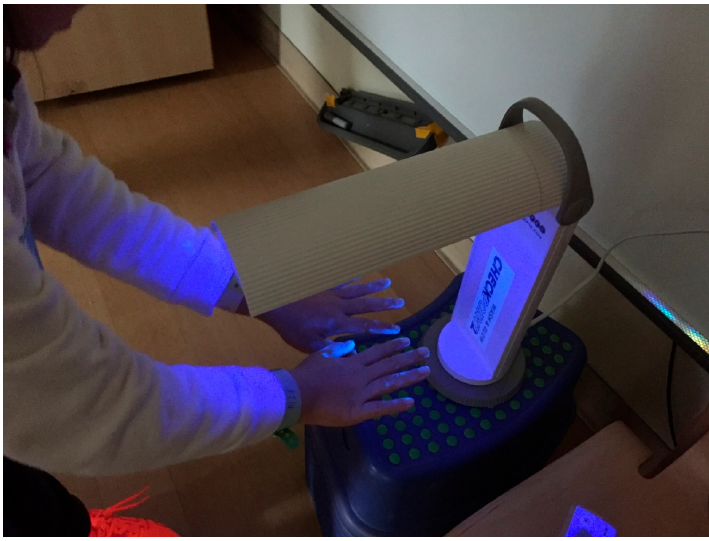
Figure 4. Hands were examined using an ultraviolet lamp (CheckPoint).